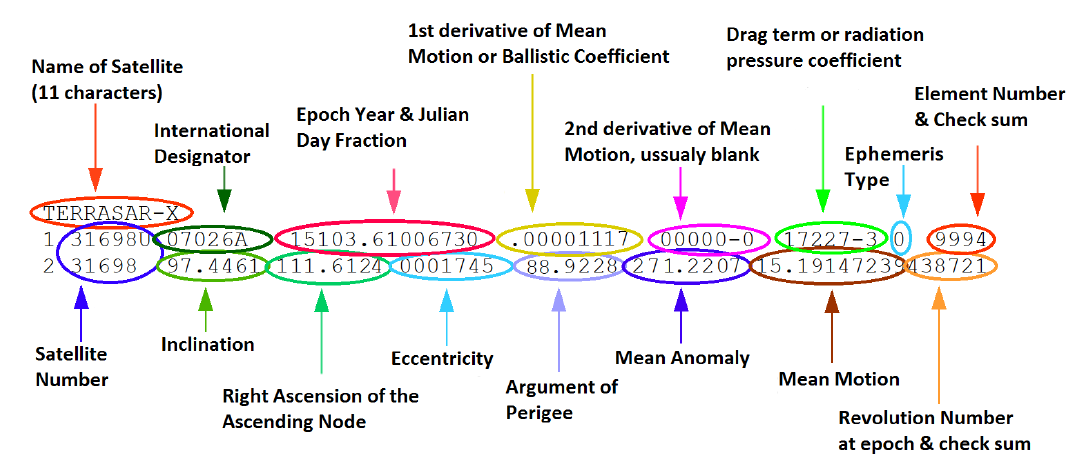
Figure 17. Two-line element (TLE) parameters for the TerraSAR-X orbit (13 April 2015)